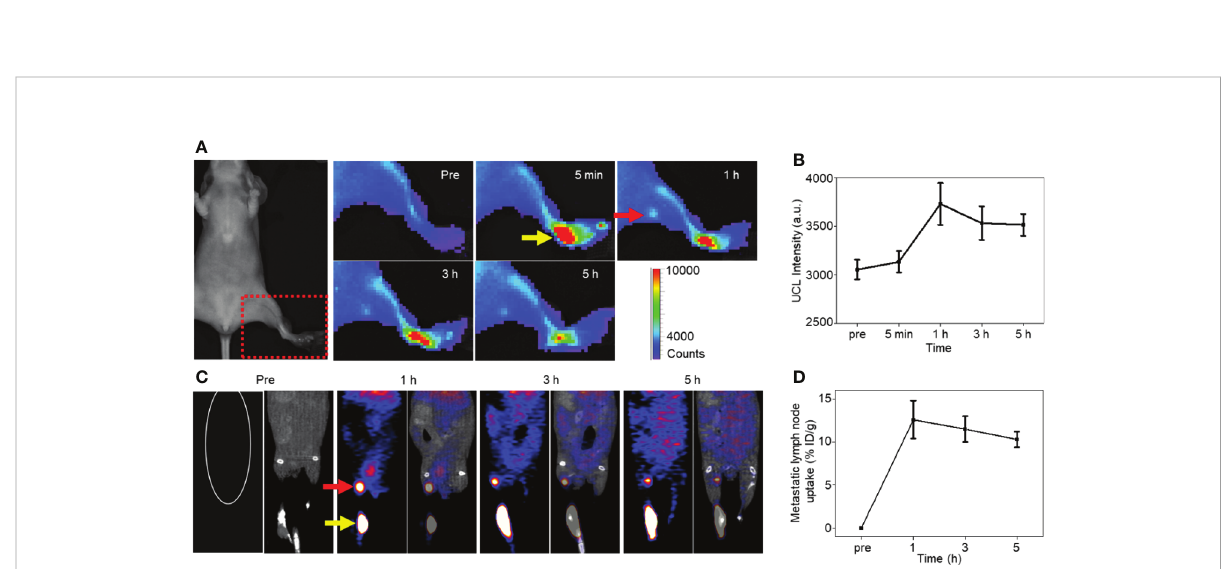
FIGURE 3 In vivo imaging experiments. (A) NIRF imaging of mice model bearing SKBR3 were obtained at different time points of NP-mAb injection (the red arrow indicates the site of metastatic lymph node, the yellow arrow indicates the injection site in foot pad). (B) Changes of upconversion luminescence signal in lymphatic metastasis after NP-mab injection. (C) PET imaging of mice model bearing SKBR3 were obtained at different time points of 68 Ga-NP-mAb injection (red arrow: lymphatic metastasis, yellow arrow: injection site in foot pad). (D) Changes of radioactive ingestion signal in lymphatic metastasis after 68 Ga-NP-mAb injection.